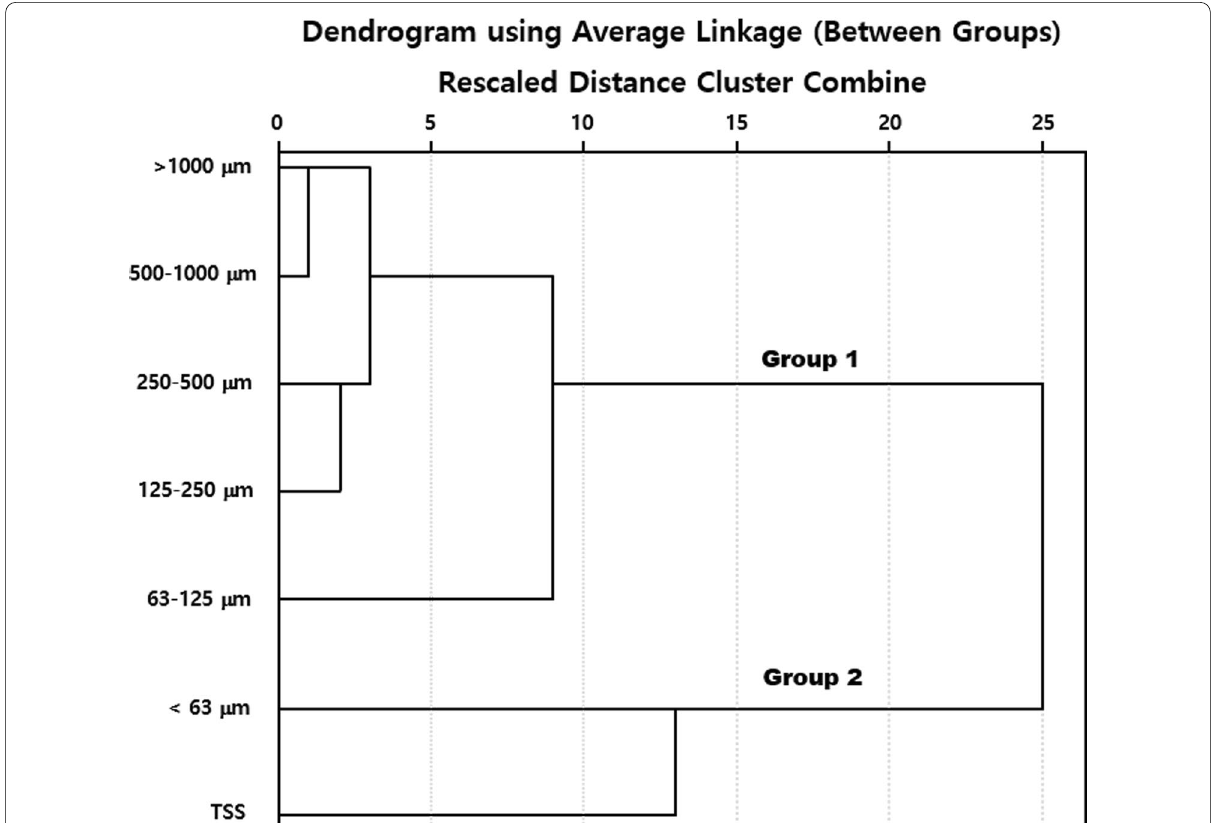
Fig. 6 Dendrogram showing clustering of the TSS in runoff and six different particle sizes of RDS in this